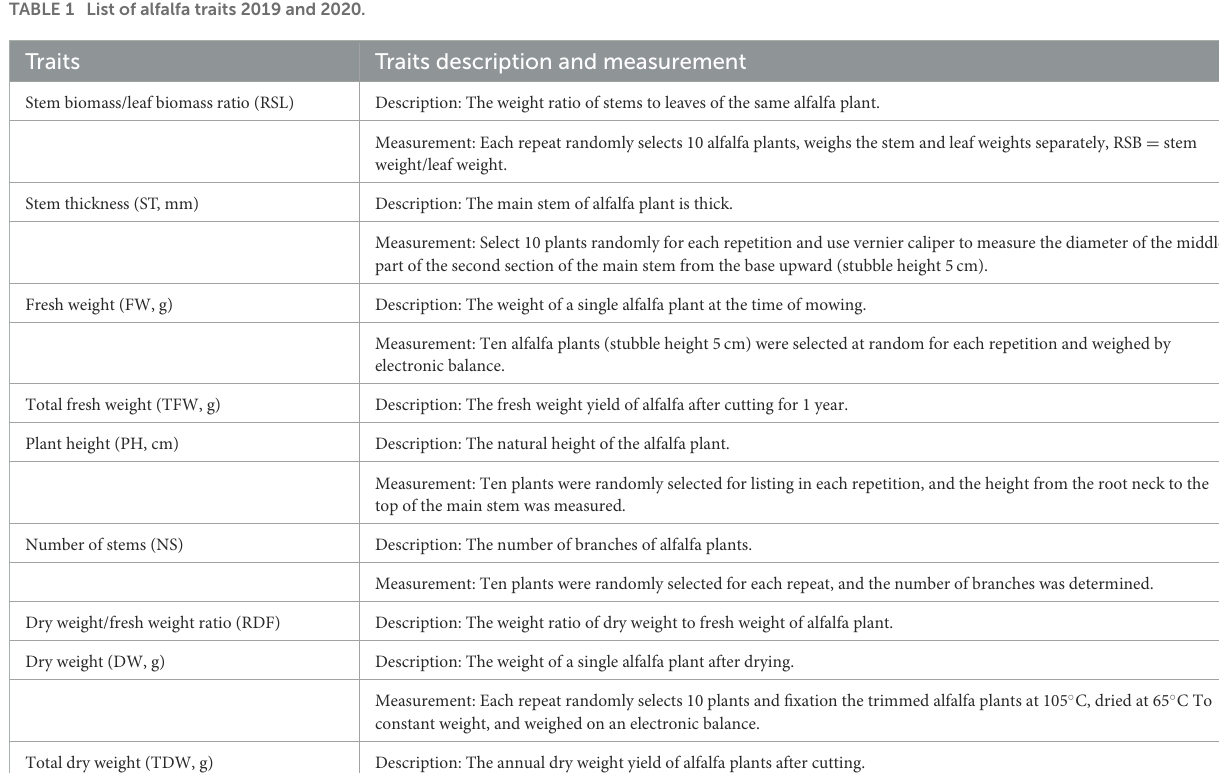
TABLE 1 List of alfalfa traits 2019 and 2020.